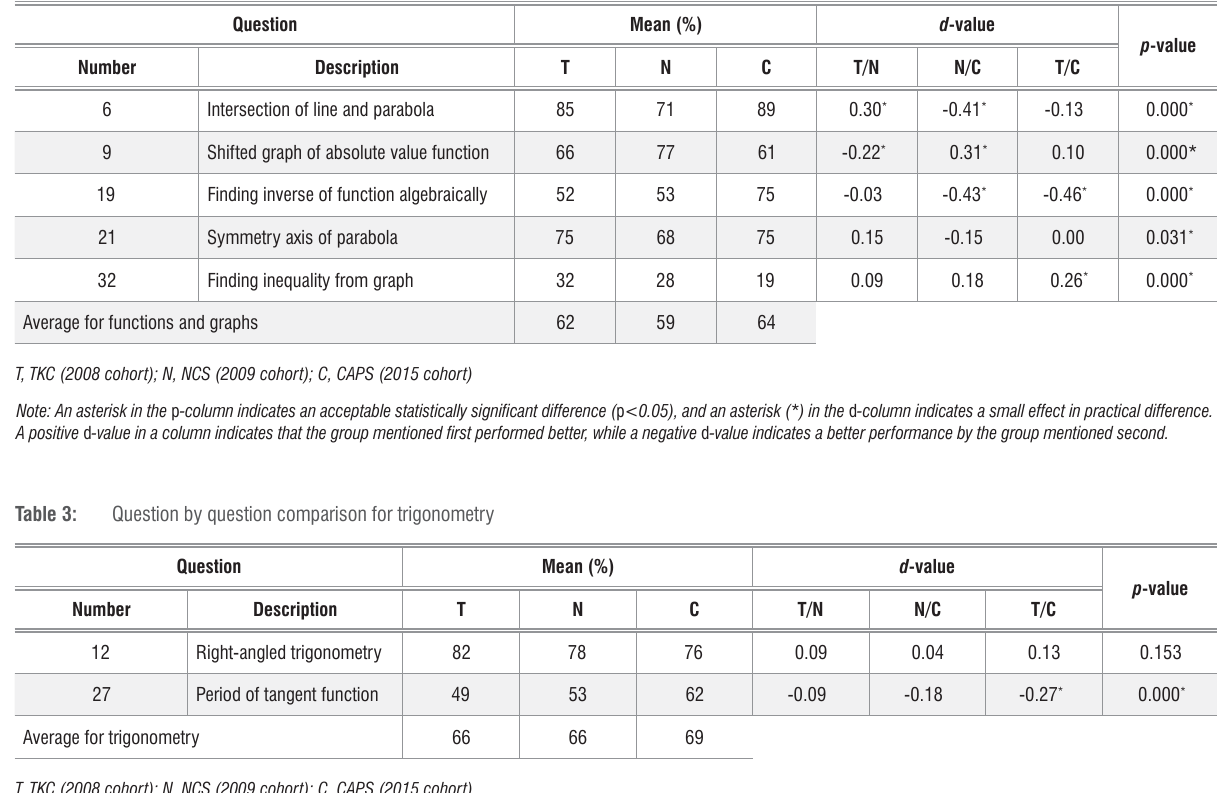
Question by question comparison for functions and graphs